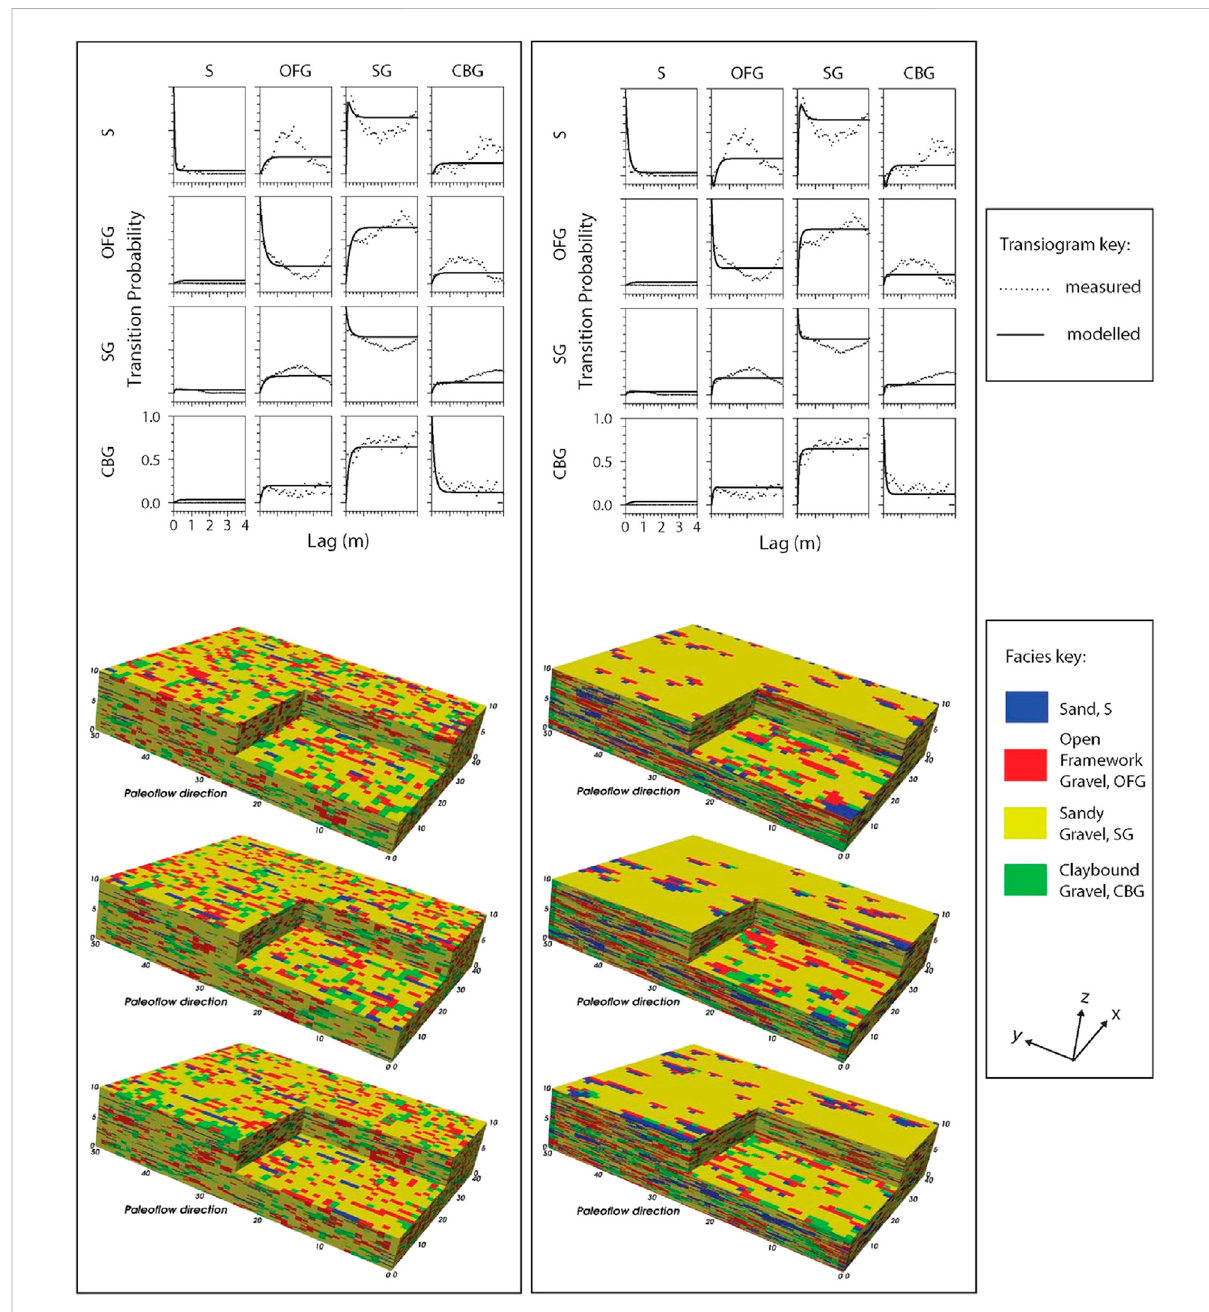
FIGURE 4 Modelled vertical transition probabilities (black line), and calculated transition probabilities from the lithological data (black dots) at the Kyle site fortwostatisticallyvalidTPmodelsareshownintheleftandrightcolumns.Theleftandright-handcolumnscorrespondtosuf fi x ‘ b ’ ,and ‘ i ’ inTable1. Below the transiograms are three heterogeneity realizations relating to the TP models shown in the